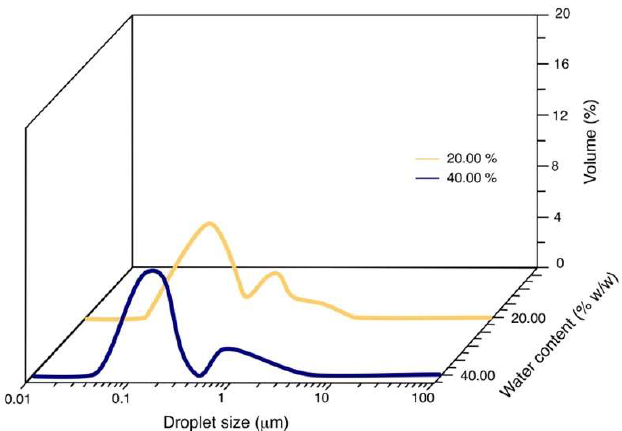
Figure 3. NE’s drop size distribution as a function of water content for the dilution line S/O 25/75.